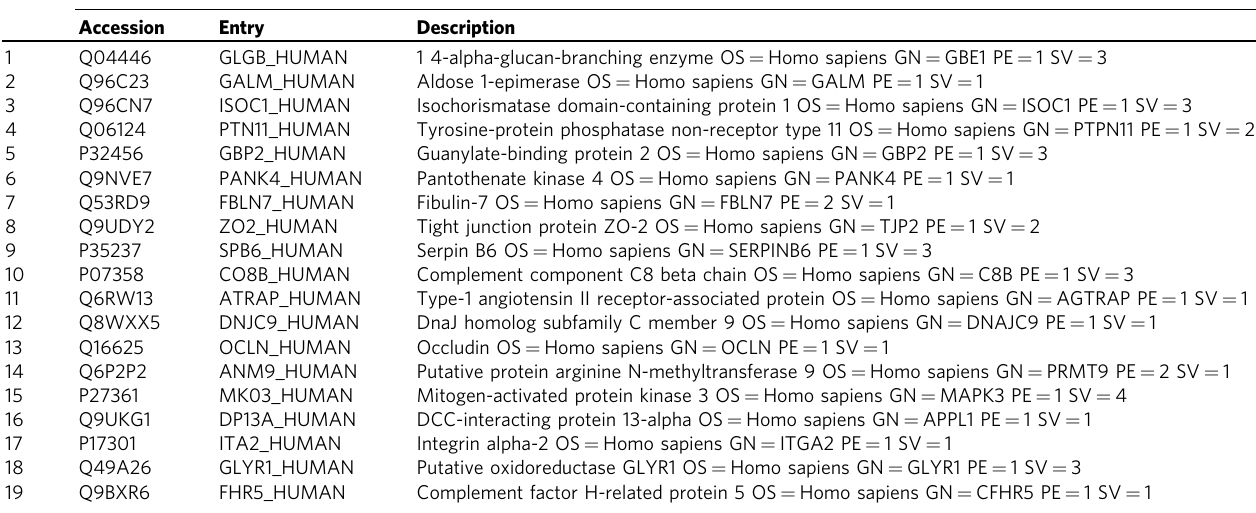
Table 3 Enlists the proteins identi fi ed only in LN metastatic patient sample through mass spectrometric studies. Protein list — metastasis